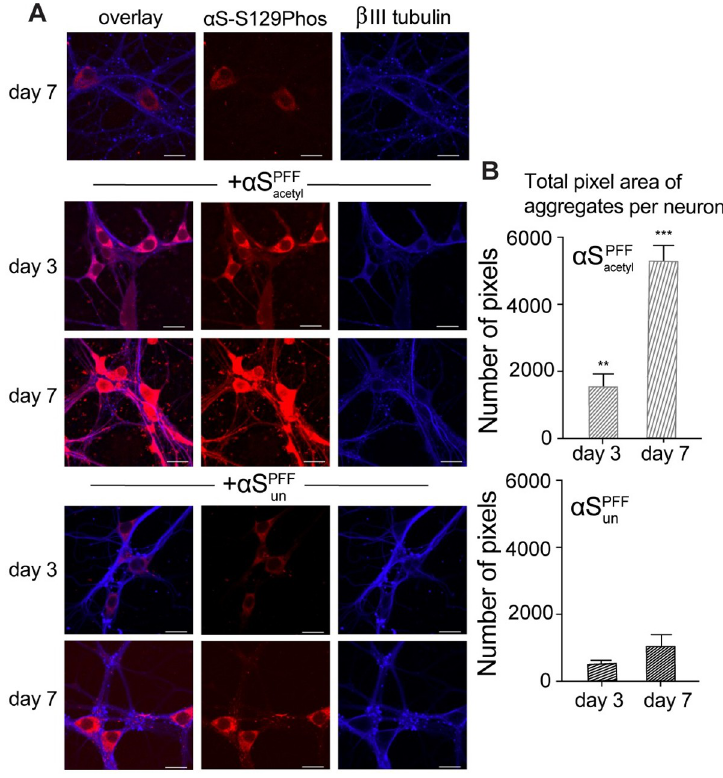
Fig 1. α S acetyl PFFs are more effective at inducing pathological aggregates in primary neurons. (A) Representative images of aggregates of endogenous α S in cultured mouse hippocampal neurons following incubation with α S acetyl or α S un PFFs. Images shown at day 7 in the absence of PFFs (upper row) and after 3 and 7 days following treatment with PFFs. Red: α S-pS129 antibody; blue: β III-tubulin antibody. (B) Quantification of α S aggregates as seen in images in (A). Aggregates in neurons treated with α S acetyl PFFs are larger and more numerous. n = 80 neurons, 3 independent experiments, �� P < 0.001 and ��� P < 0.0001 by Student t test compared to α S un PFF-treated neurons. The data are presented as mean ± SD, n = 3. Scale bars = 20 μ m. The underlying data for this figure can be found in S1 Data. α S, α - Synuclein; α S-pS129, α S phosphorylated at serine 129; α S acetyl , N-terminally acetylated α S; α S un , unmodified α S; PFF, preformed